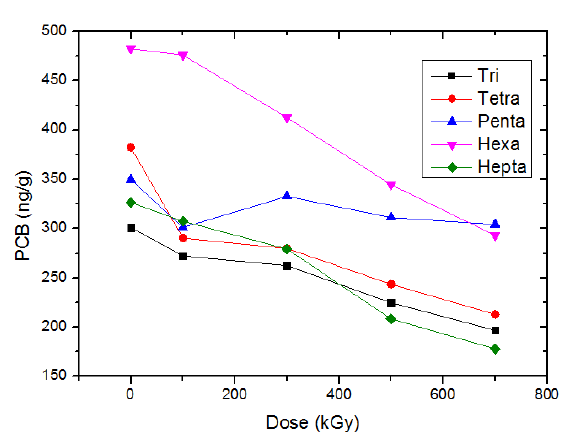
Figure 4. Concentration of PCB groups in soil samples chemically pretreated by CuSO 4 · 5 H 2 O and K 2 CO 3 as a function of increasing dose of